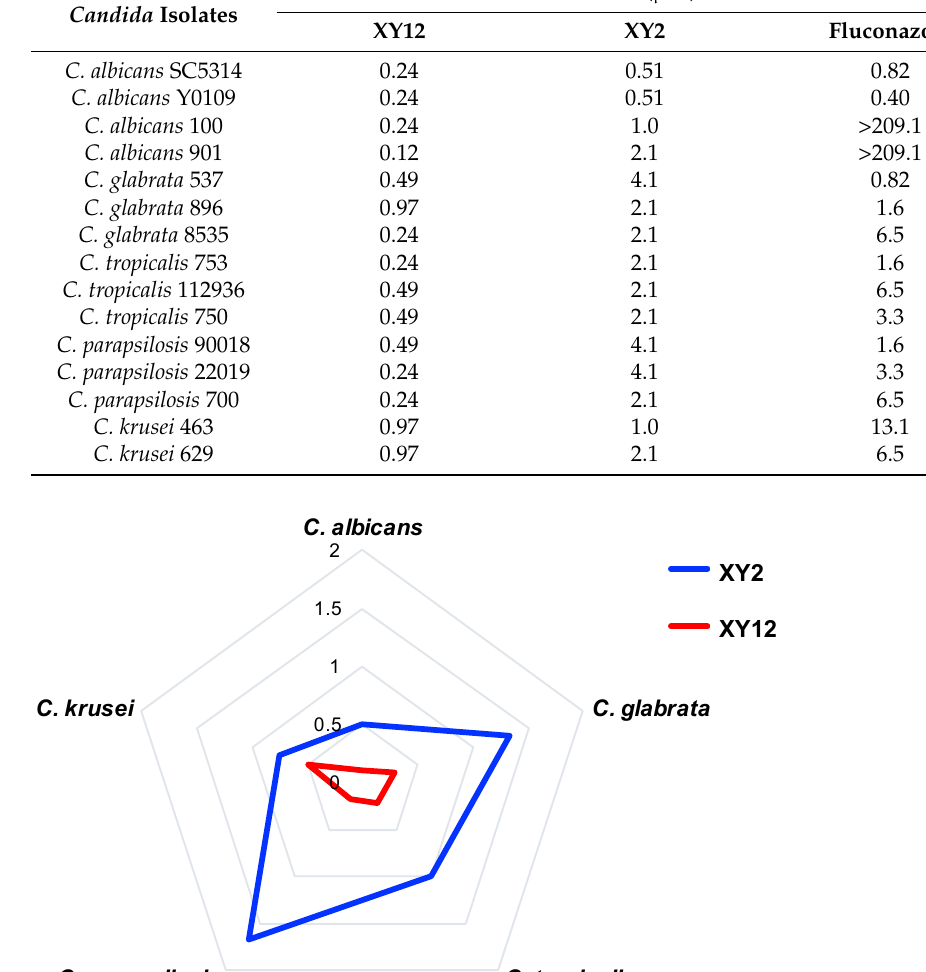
Table 2. Antifungal activity of XY14 against Candida.